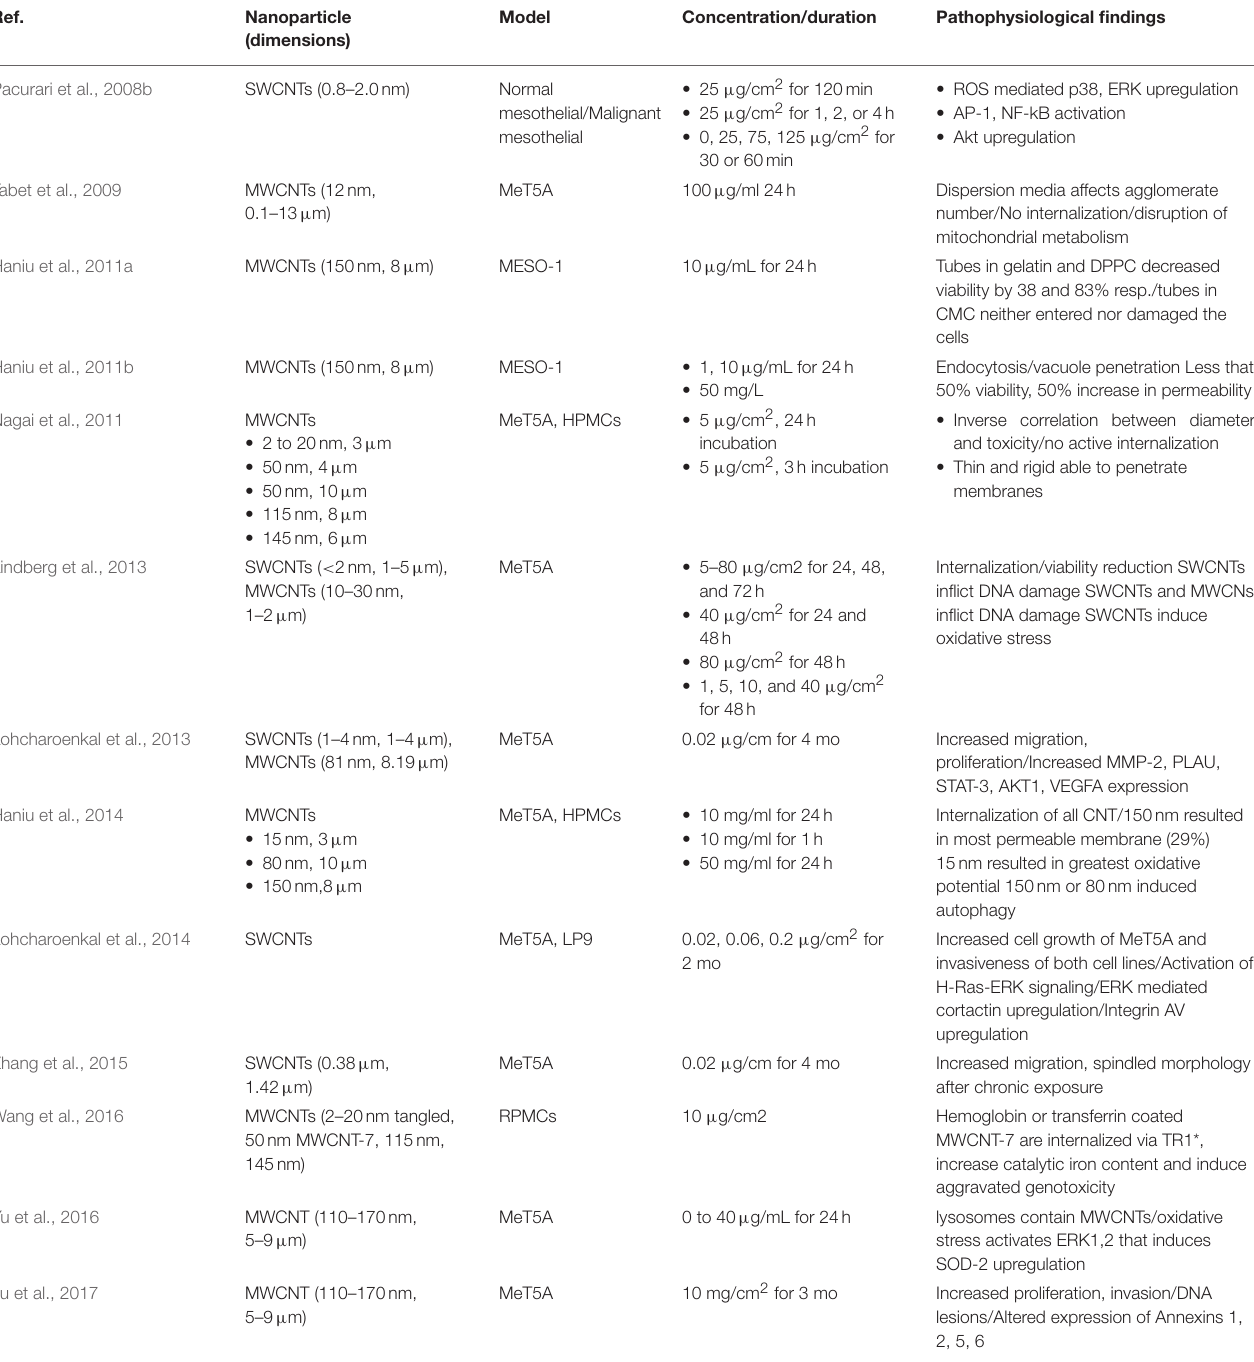
TABLE 1 | In vitro studies describing CNT toxicity on mesothelial cells (minute = min, hour = h, month = mo) * transferrin receptor 1.